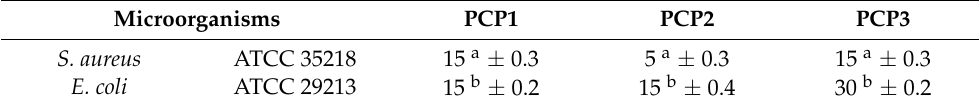
Table 3. Antimicrobial activity of polyphenols from Chilean propolis in PCP1, PCP2 and PCP3 on bacterial